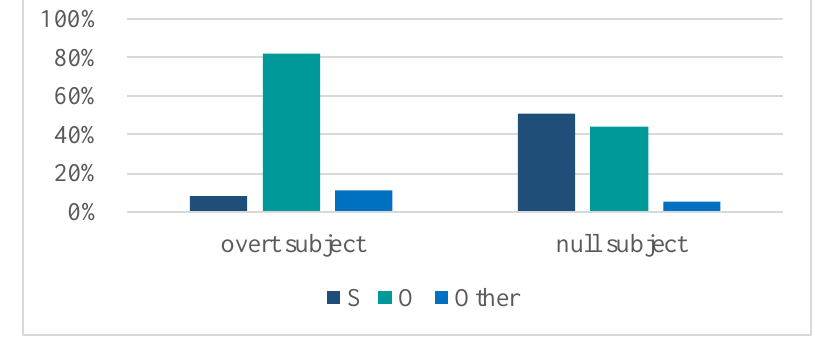
Figure 1 . Anaphoric resolution of overt and null subject pronouns in native Italian